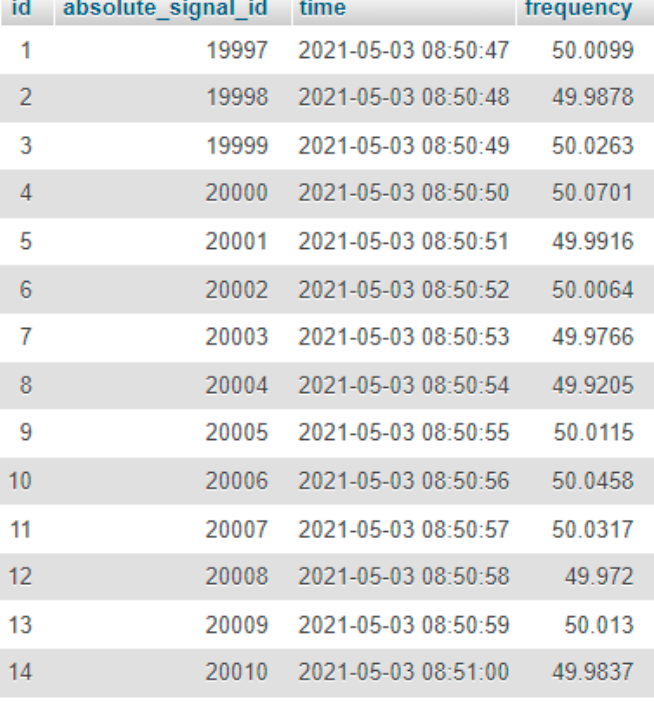
Table 1. Allan frequency table (offline measurements) for one month, extracted from Grafana database. It keeps its original format.